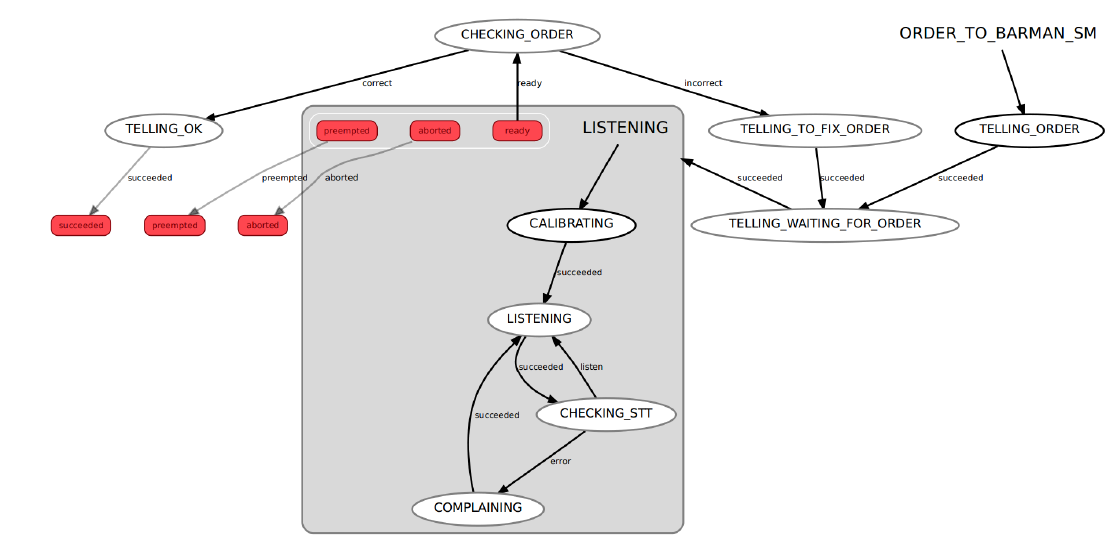
Figure 7. SMACH Viewer presentation of the FSM of the order to barman